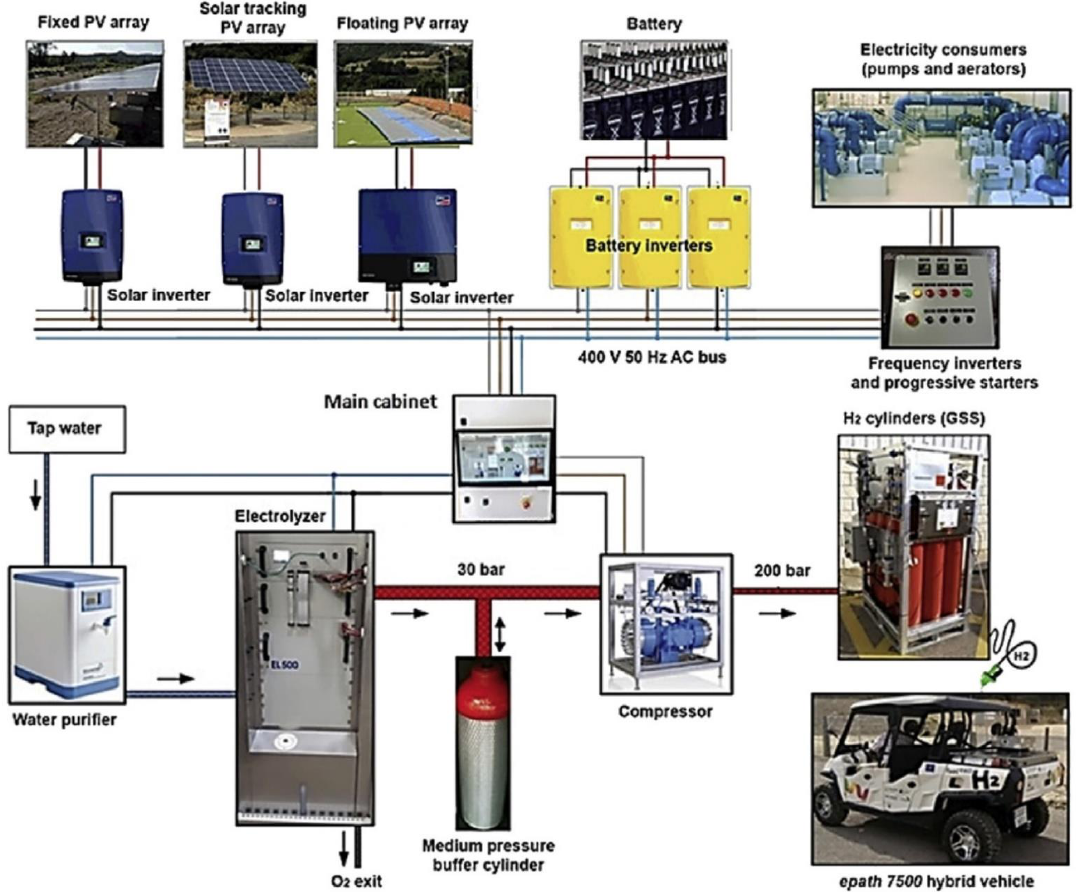
Figure 7. Schematic representation of a power-to-gas PV-RHFC microgrid system with batteries, and fuel cell electric vehicles. Reprinted with permission from Ref. [41]. 2018, Elsevier.